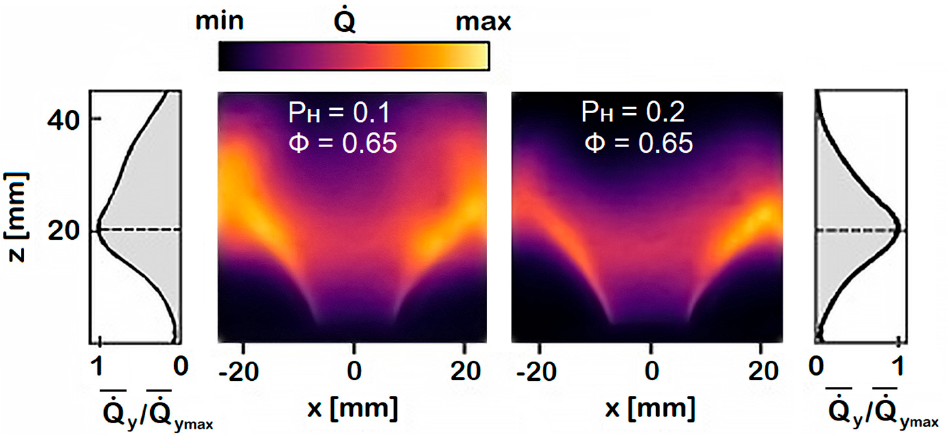
Figure 12. The average flame shapes and corresponding longitudinal distributions of the integral heat release rate for two stable operating conditions [28].